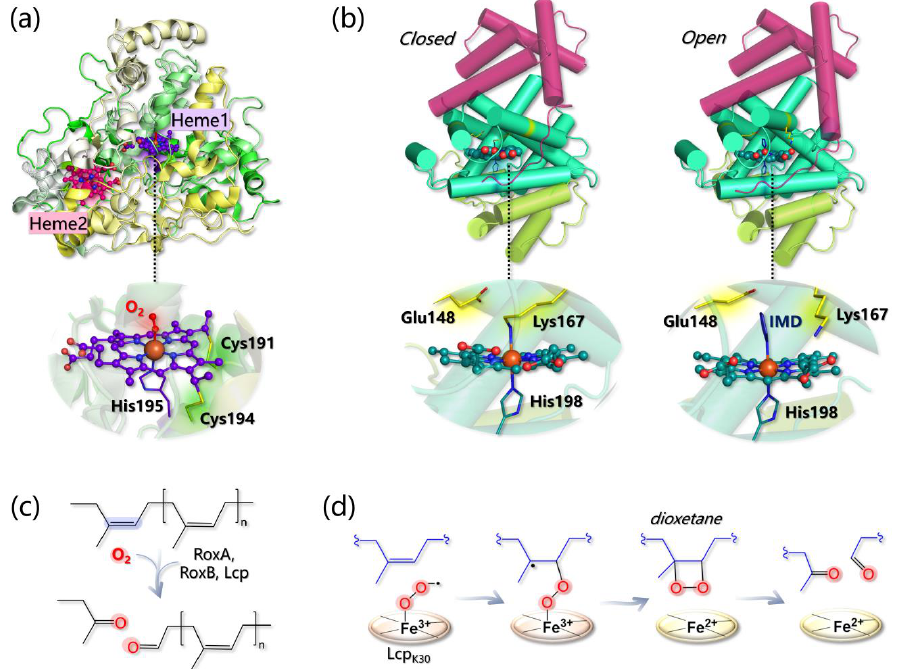
Figure 12. ( a ) Structure of RoxA (PDB 4B2N) and detail on heme1 coordination. ( b ) Closed (left) and open (right) conformations of Lcp (PDB 5O1L and 5O1M, respectively). IMD refers to the axial im- idazole ligand of heme, that is found in the 3D structure of the open state. In both states, the globin core, containing the heme active site, is colored in green-cyan, while the other three- and six-helices domains are colored in light green and purple, respectively. ( c ) General mechanism of dioxygena- tion by RoxA, RoxB, and Lcp. ( d ) Energetically favored pathway as calculated in [283]. Lcp architecture is definitely different from the one of RoxA/B and, as indicated by the crystal structure of an Lcp from Streptomyces sp. K30 (the only one available), the pro- tein core is characterized by a canonical globin fold formed by eight helices labeled from A to H in analogy with hemoglobin (Figure 12b) [284]. Both the N- and C-terminus are additional domains of three and six helices, respectively, with unknown function. In con- trast to RoxA/B, only one type-b heme group is found in Lcp, and it is predicted to have a different coordination environment according to the conformation assumed by the whole protein. Indeed, the Lcp 3D structure has been solved in both a “closed” and an “open” conformation: in the former, Fe is axially bound to His198 and Lys167, while in the latter, Lys167 is not coordinated and the accessibility to the heme is increased. The open state